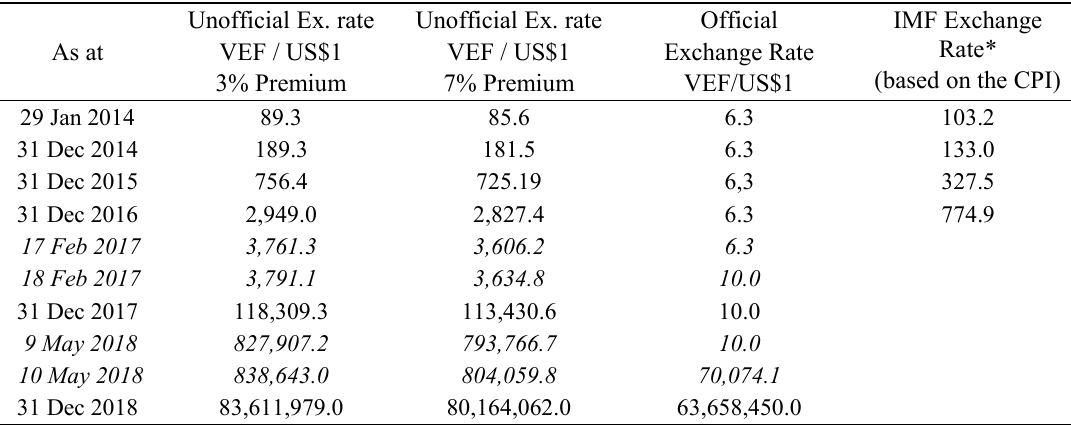
Table 6. Venezuela: Official and Unofficial Exchange Rates: 2014 - 2018 Unofficial Ex. As at